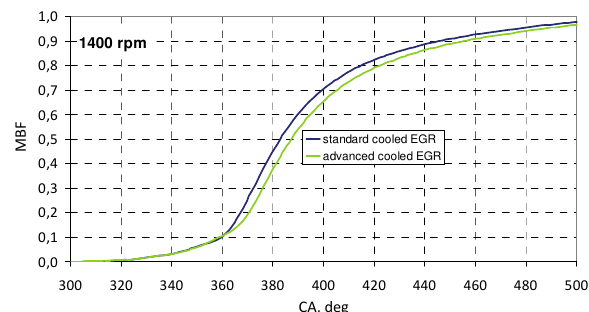
Fig. 19. Impact of EGR cooling system at differential pressure Pd (engine rotational speed: 900 rpm, 190 Nm load)